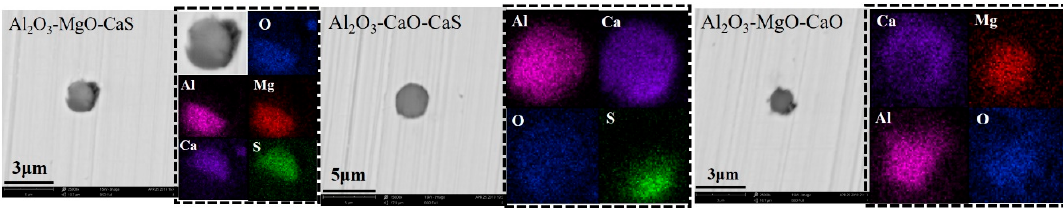
Figure 3. SEM images and energy-dispersive spectroscopy (EDS) maps of the typical inclusions in A2.